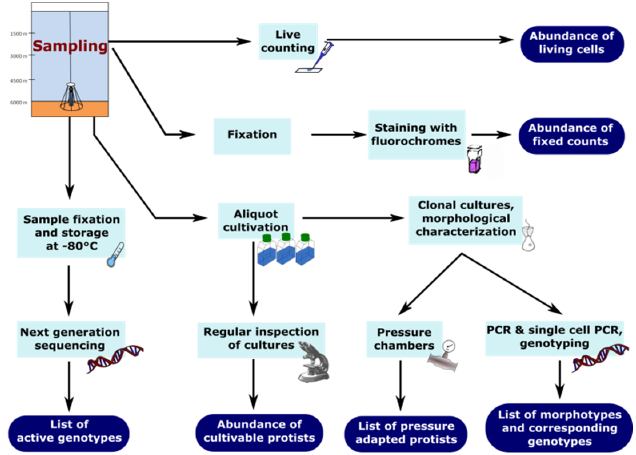
Figure 4. Proposed protocol for diversity and abundance estimates of deep ‐ sea nanoprotists including molecular surveys (such as environmental RNA), fixation, live ‐ counting and aliquot cultivation.